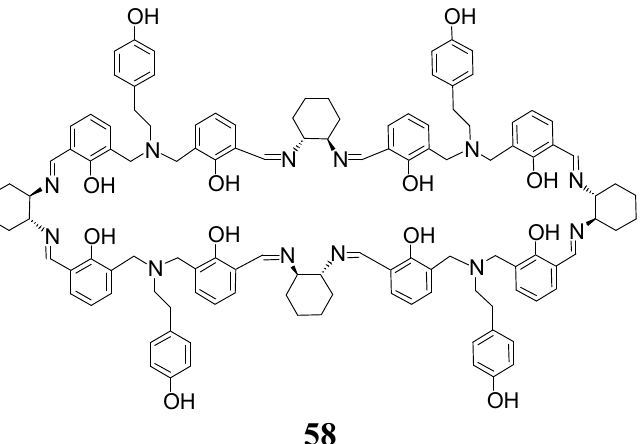
Figure 25. [4 + 4] imine obtained in anion-dependent template condensation with zinc(II).